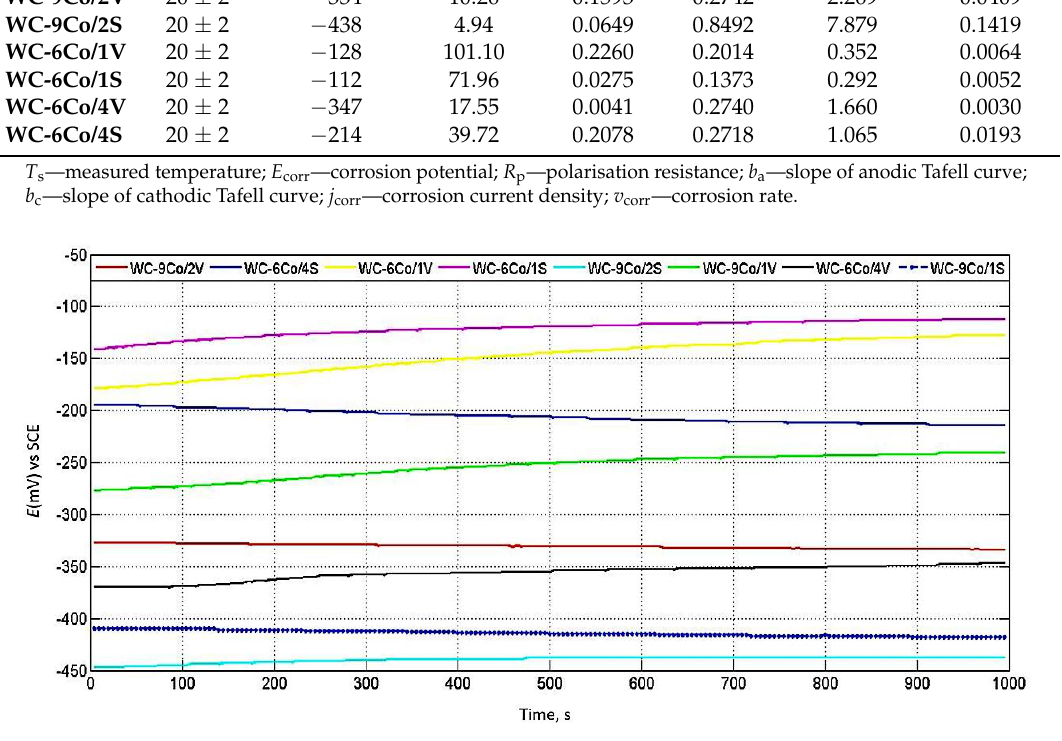
Table 3. The results of electrochemical DC techniques.